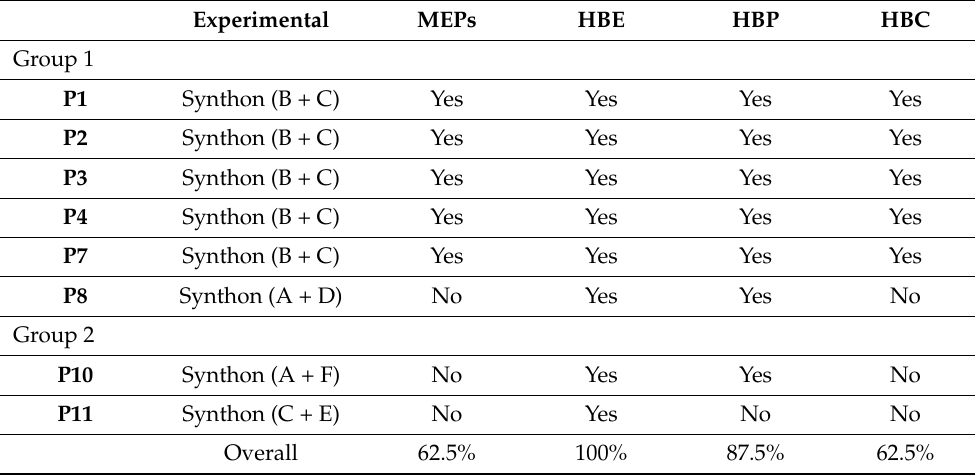
Table 3. Experimental vs. predicted synthons in the crystal structures of P1 – P14, P7 – P8 and P10-P11.